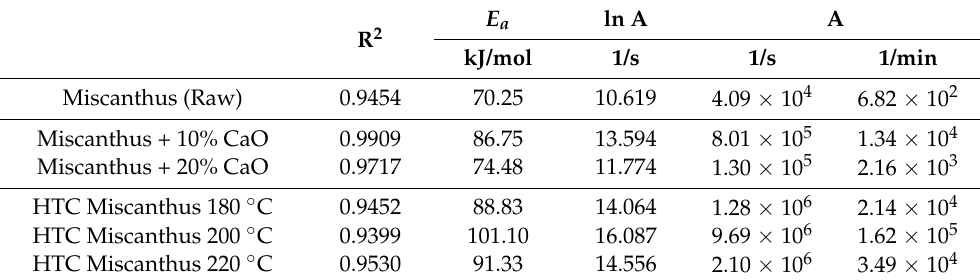
Table 1. Activation energy and pre-exponential (frequency) factor for fast pyrolysis of Miscanthus.